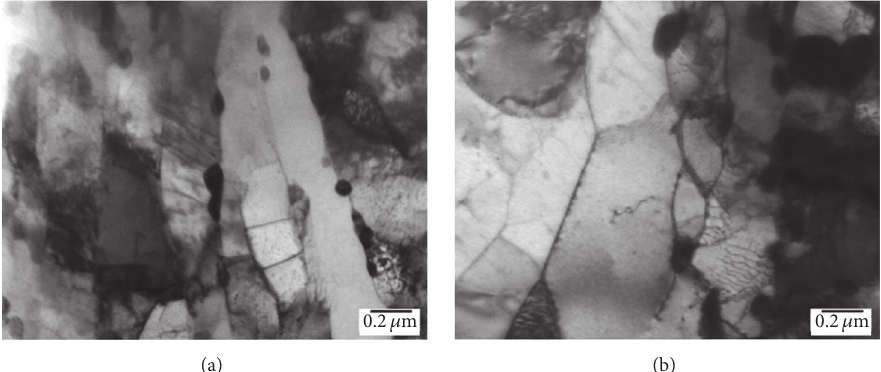
Figure 18: Bright field TEM images of CB2 BM substructure in initial PWHT state (a) and after the creep test at 625 ∘ C, 80MPa for 18864 h of the preaged (625 ∘ C/30 kh) material